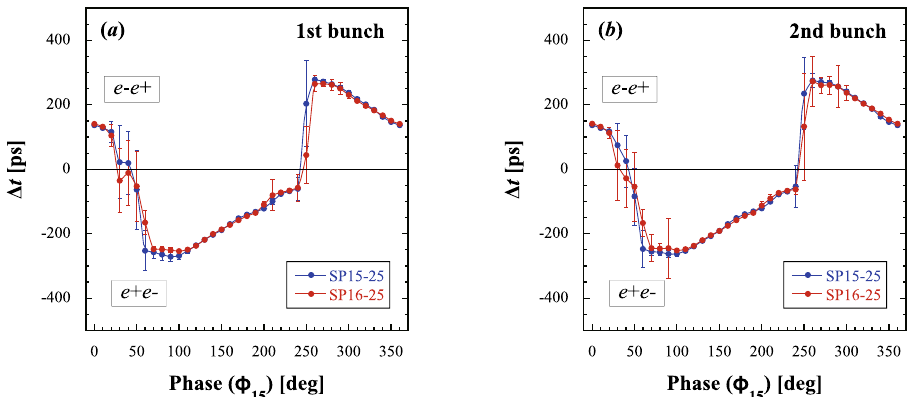
Figure 3. Variations in the time interval between the e − and e + ( a ) first and ( b ) second main bunches due to the dynamical phase-slip processes as a function of (cid:31) 15 at SP15-25 and SP16-25. The solid curves drawn through data are guide to the